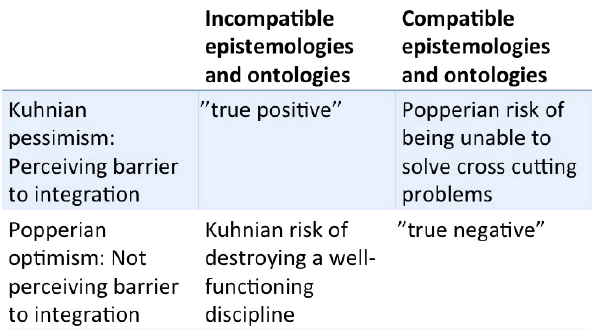
Fig. 1 . The interdisciplinary decision